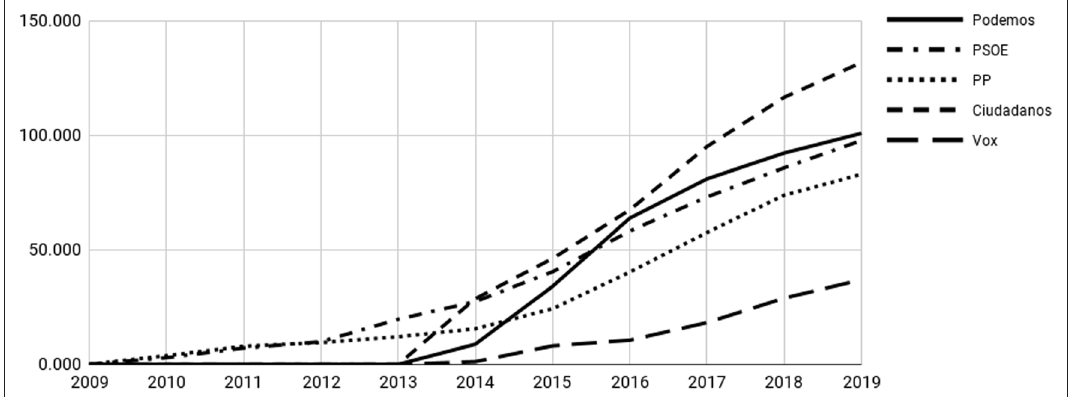
Figure 2: Number of Tweets per Account by Year,